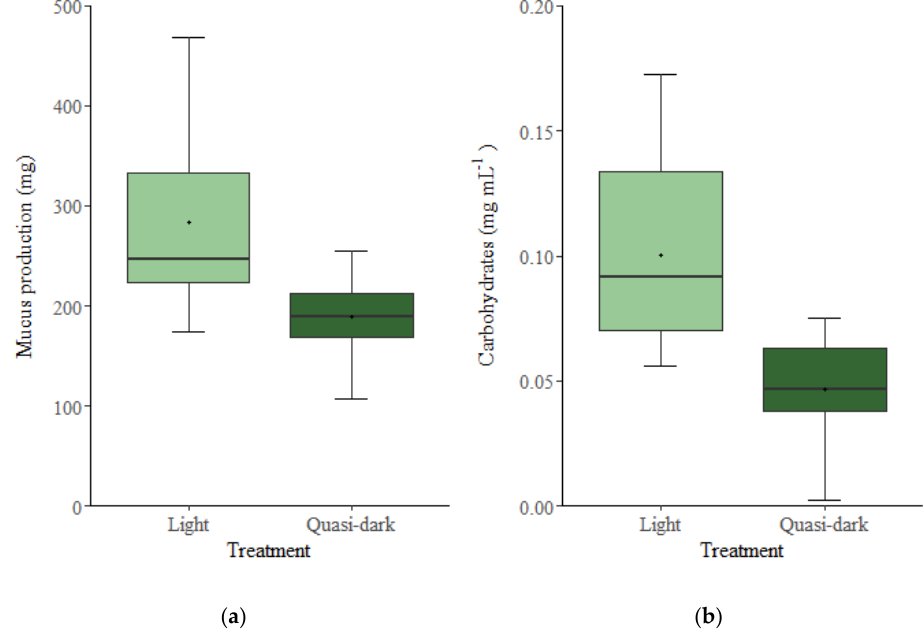
Figure 2. Mucus production ( a ) and mucus total carbohydrate content ( b ) in the sea slug Elysia crispata reared for five weeks under light (60–90 μ mol photons m − 2 s − 1 ) and quasi dark (5 μ mol photons m − 2 s − 1 ). The sea slugs were fed ad libitum with the macroalga Bryopsis plumosa . The line is the median, the + represents the mean, top and bottom of the box are the 75% and 25% percentiles, respectively, and the whiskers represent the maximum and minimum values ( n = 15).